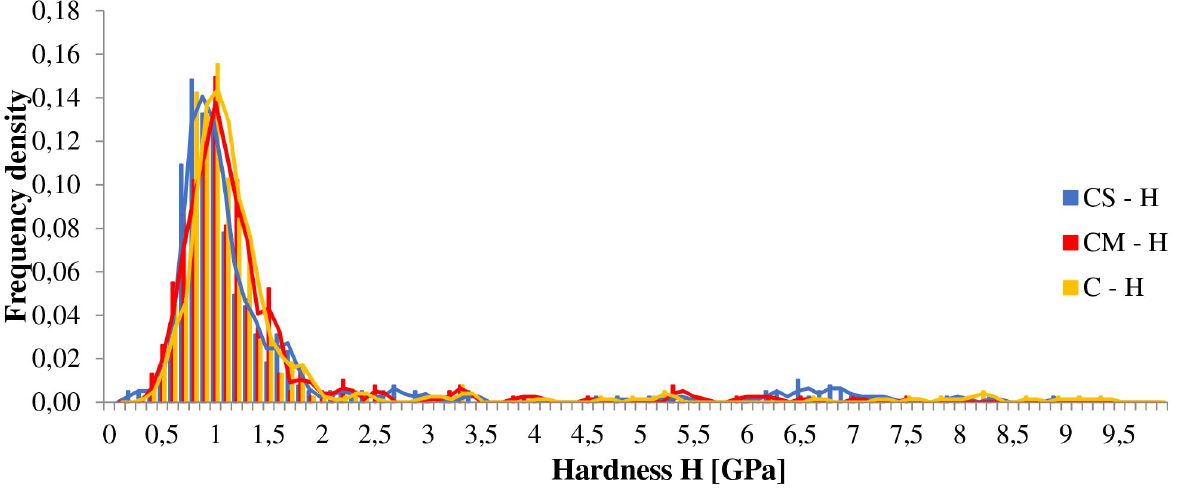
Figure 9. Histogram of hardness with trend line for cement pastes CS, CM and C.